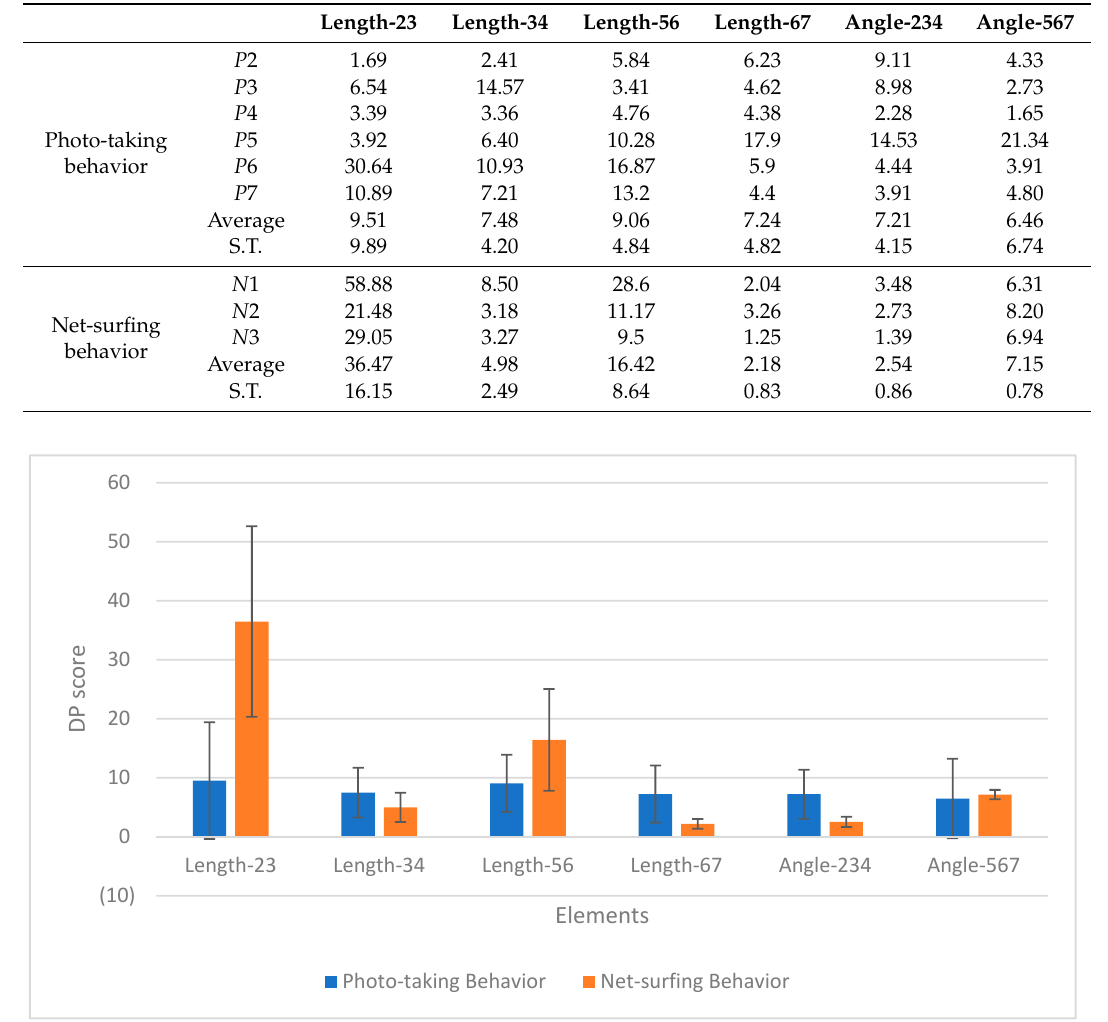
Figure 16. Average DP score for each behavior obtained from the results in Table 3 (reference data: P1).